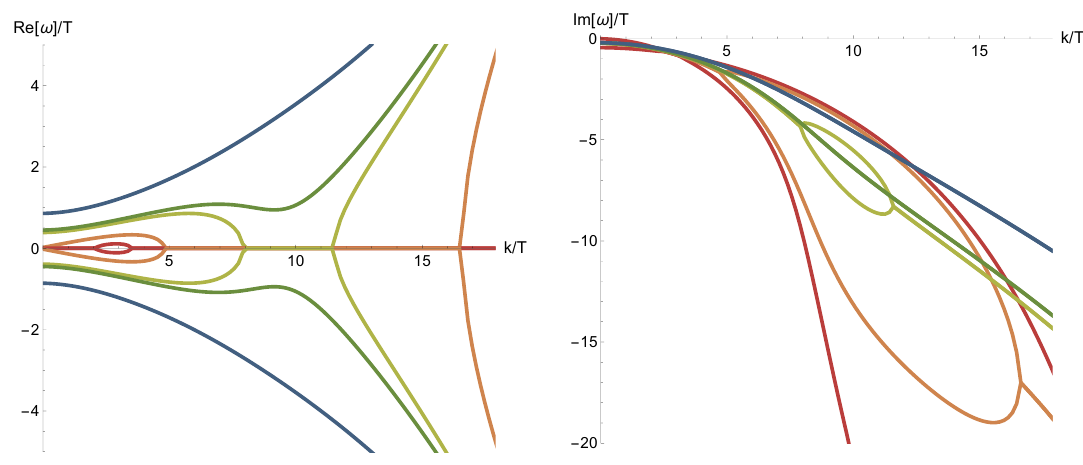
Figure 4 . The real ( left ) and imaginary ( right ) parts of the frequencies of the two lowest QNMs at (cid:12) = 20 for T=m 2 [2 : 89 ; 68 : 27] (blue-red).